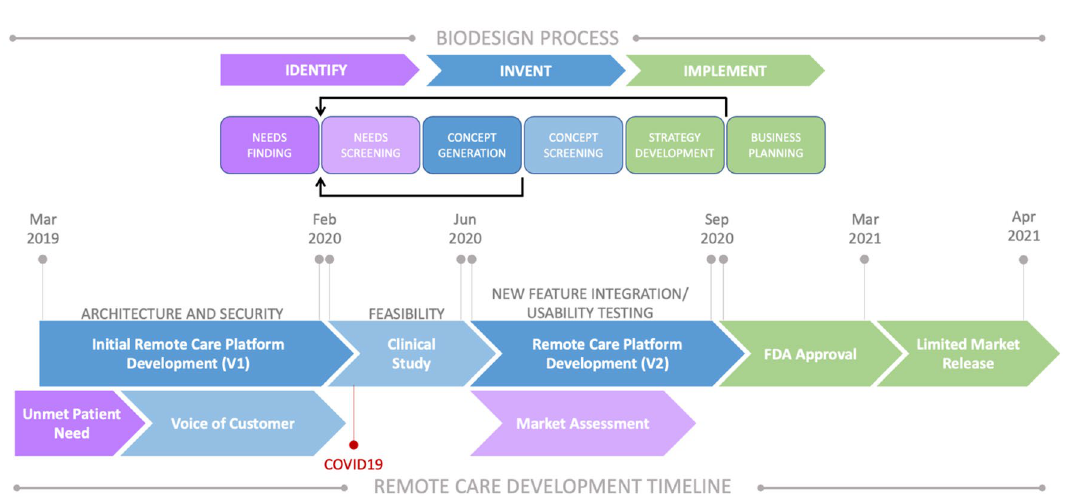
Figure 1. Development timeline of the Remote Care platform. The iterative development process of the remote care platform aligned with the biodesign process (adapted from Yock et al. 2015 24 ). (1) We identified the unmet patient need related to care access burden; (2) We designed an initial prototype version of the platform in parallel with collecting voice-of-customer data and tested its feasibility in a real-world setting through a pilot study; (3) We integrated lessons learned from the study into a second iteration of development focused on new feature integration and usability analysis; (4) Lastly, we gained FDA approval for the remote care platform and collected preliminary data for the limited market release experience.